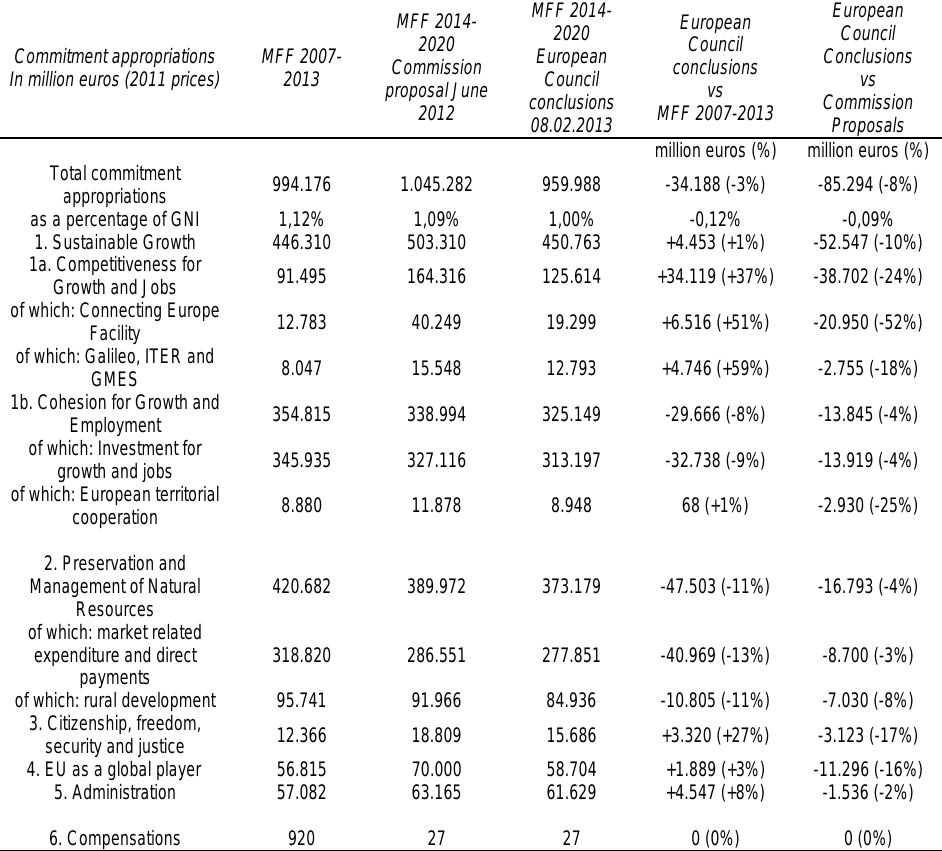
Table 2. MFF 2014-2020: comparisons (€m)